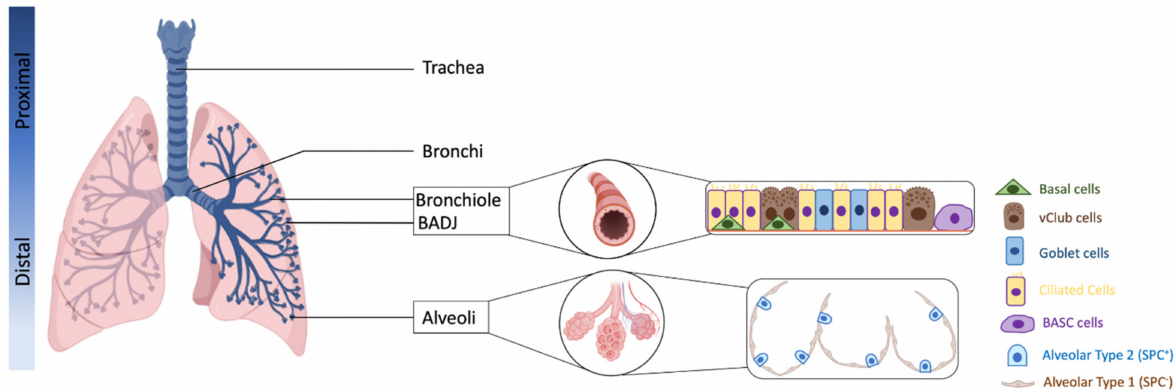
Figure 1. Schematic anatomy of the lung and cellular composition of the airway epithelium (created with BioRender.com, accessed on 15 February 2022).